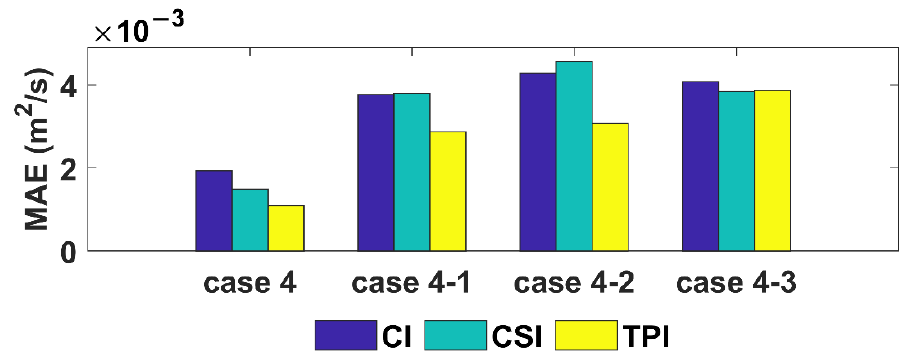
Figure 4. The MAEs between the given and inverted VEVCs with three schemes in Cases 4, 4-1, 4-2, and 4-3.